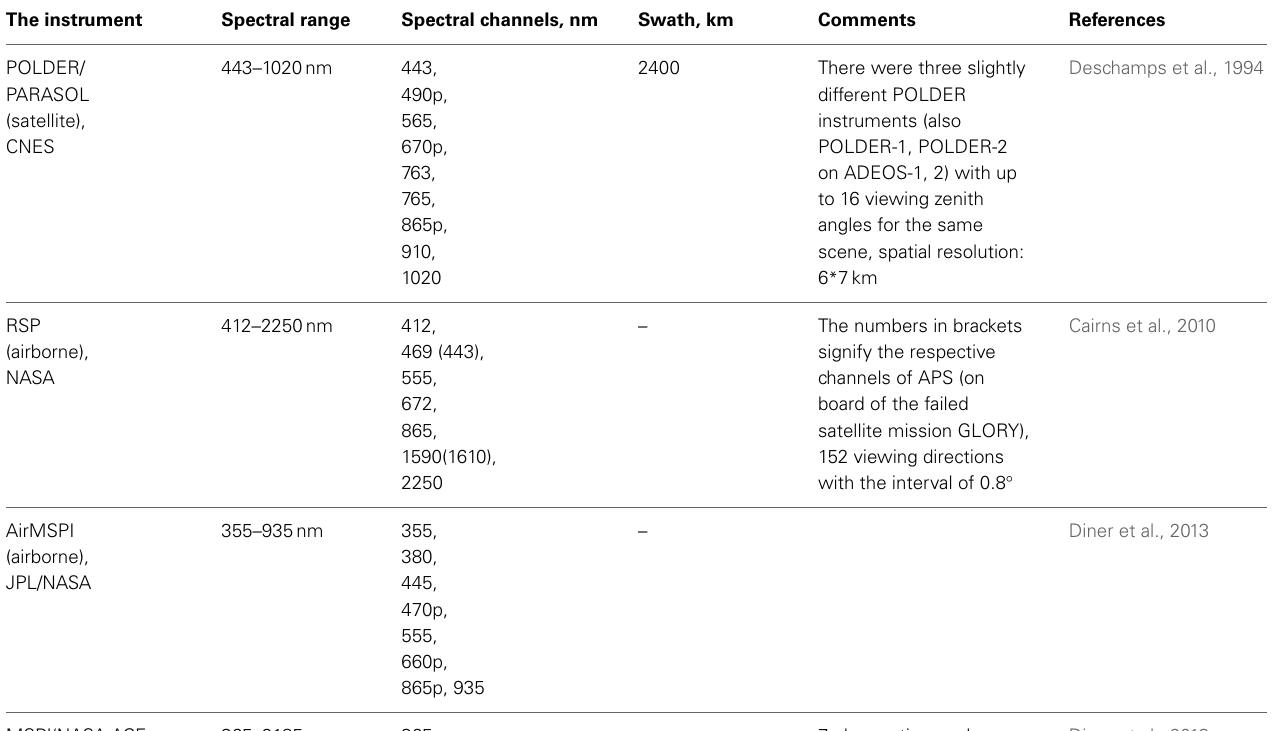
Table 1 | The characteristics of airborne and spaceborne polarimeters (the index “p” means that the measurements of I, Q, U are performed at a given spectral